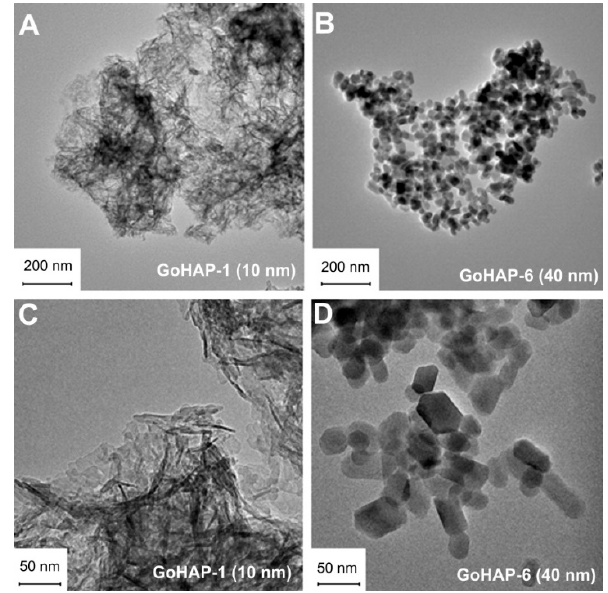
Figure 3. HR TEM image of GoHAP™ with different particle sizes of 10 nm ( A,C ) and 40 nm ( B,D ).